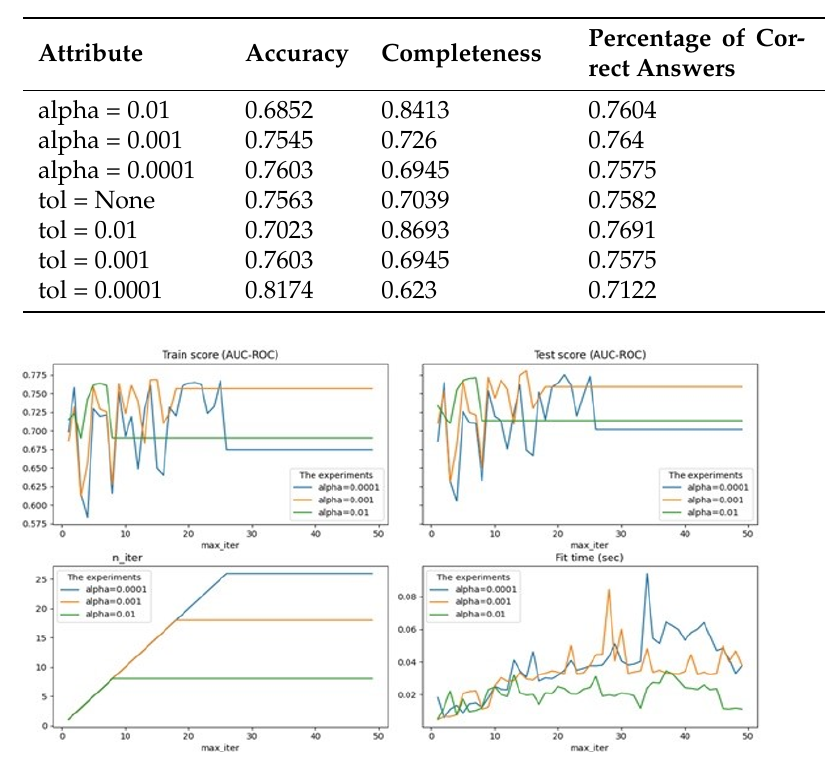
Table 6. Results of experiments on model attributes.